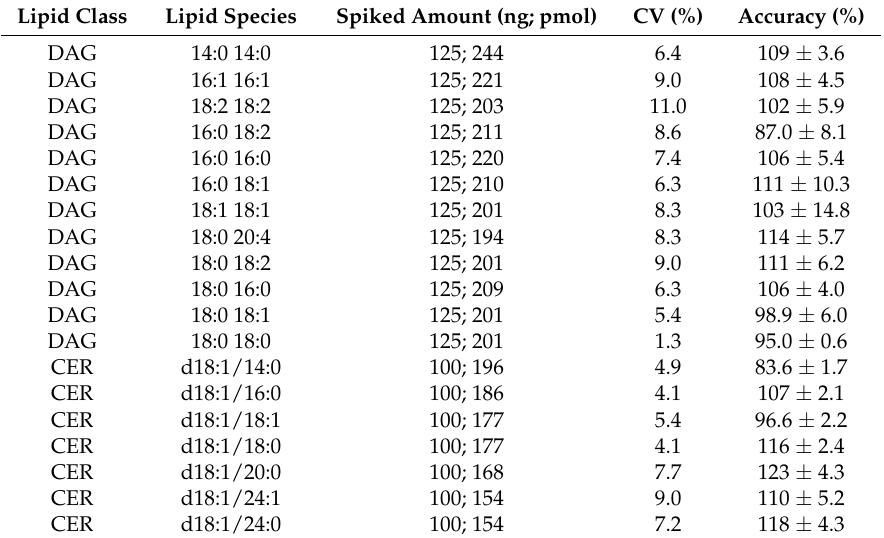
Table 4. Precision and